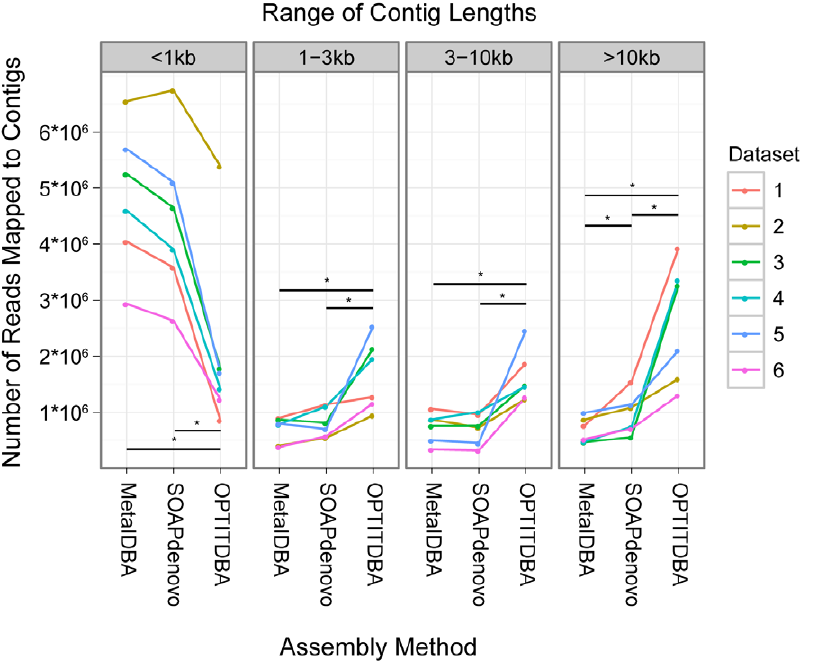
Figure 2. Comparison of assembly methods by read alignment. The vertical axis indicates the number of reads from each dataset that align to contigs of different size classes (either less than 1 kb, between 1 kb and 3 kb, between 3 and 10 kb, or longer than 10 kb). The horizontal axis separates assembly method. Each dataset is indicated by color (see key on right; numbers indicate gut virome communities from different human subjects). * indicates p , 0.05 by Wilcoxon signed-rank test for the indicated pair of assembly methods.